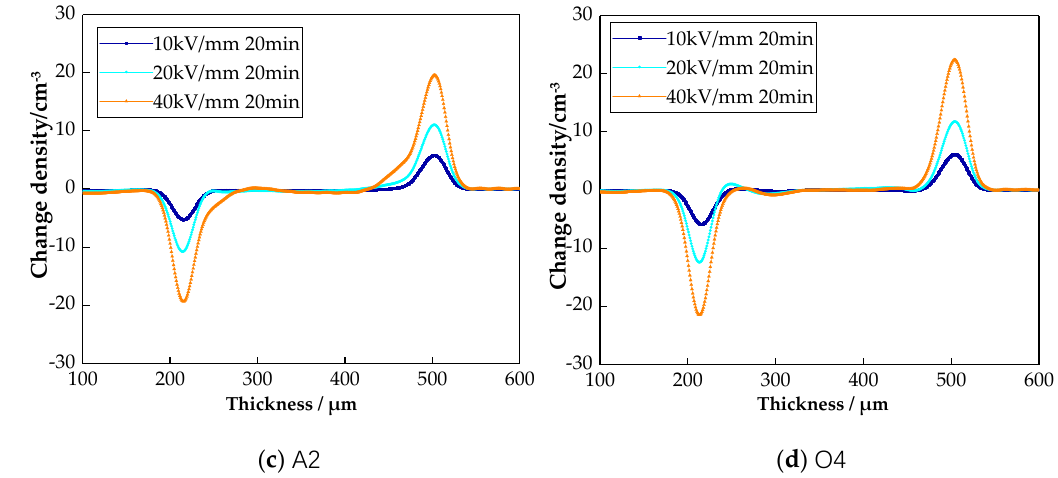
Figure 7. Space charge accumulations of LDPE under an electric field and different cooling media.